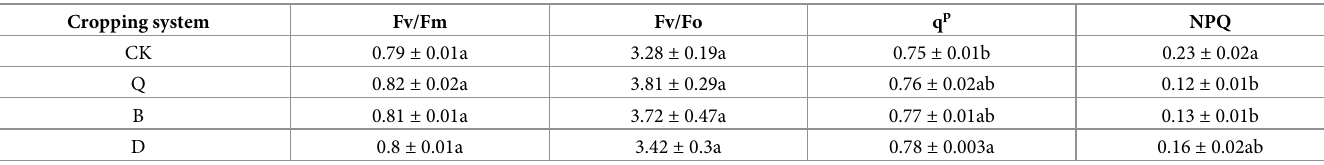
CK: Continuous tomato cropping; Q: Celery/tomato rotation; B: Cabbage/tomato rotation; D: Kidney bean/tomato rotation; Fv: Variable fluorescence; Fm: Maximum fluorescence; Fo: Initial fluorescence; q p : Level of photochemical quenching of photosystem II; NPQ: Non-photochemical quenching. Different lowercase letters at each phenological stage indicate that the differences are statistically significant (P <